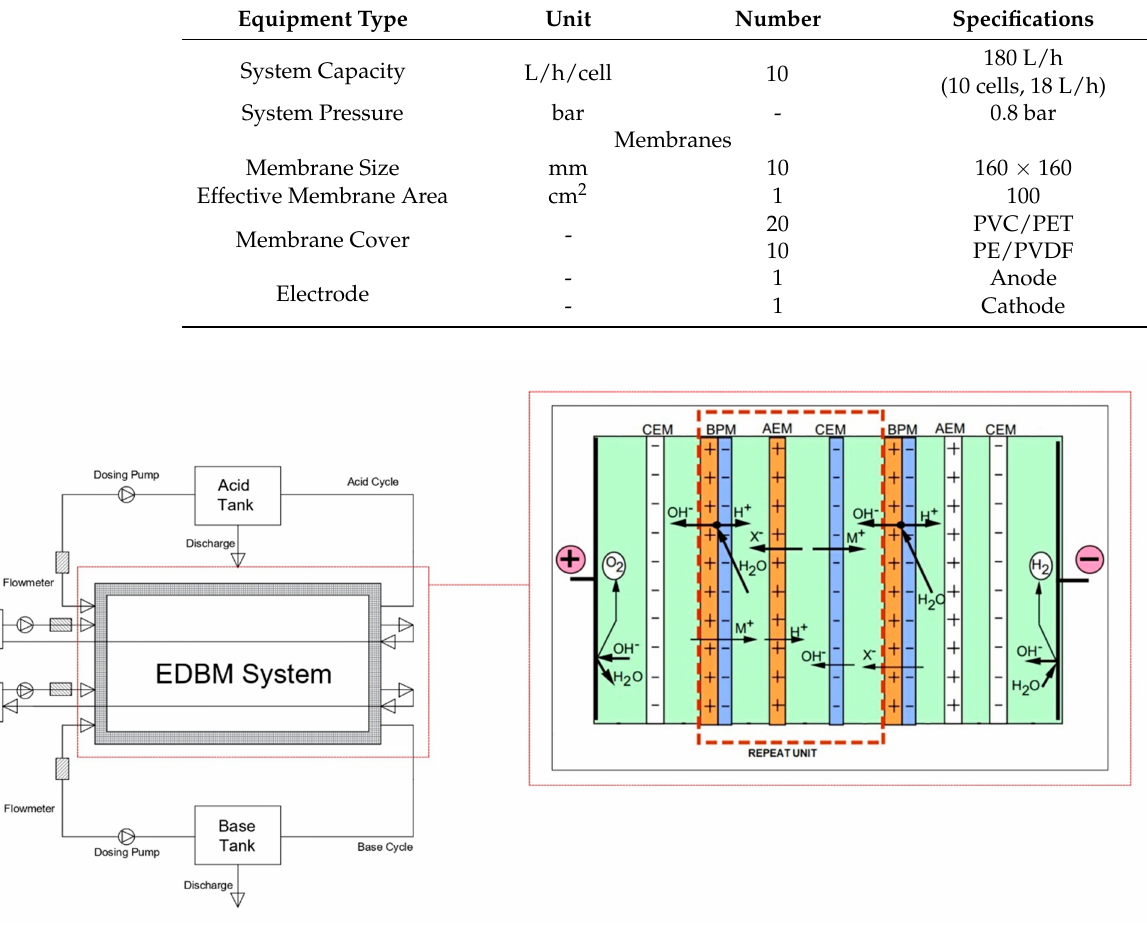
Figure 2. The operating cycle of the EDBM system